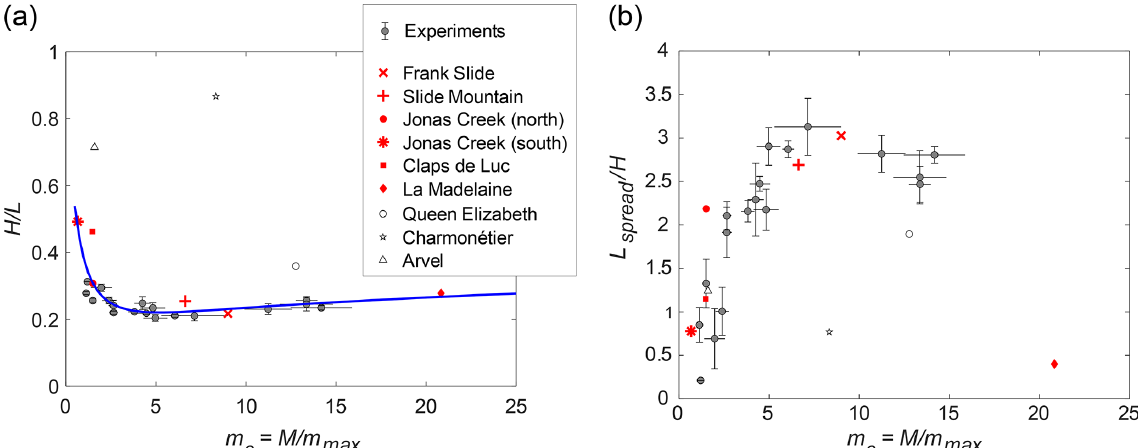
Figure 3. Heim’s ratio and the deposit length of experiments (this study) and natural rock avalanches (from Locat et al., 2006). (a) The Heim’s ratio of the analogue experiments (grey) and from the rock avalanches (red shows the selected set, and open shows discarded avalanches). The blue line represents the best fit of Eq. 8 to experimental and natural data with parameters α = − 1 . 0, β = 1 . 5, γ = 0 . 11. (b) The deposit’s lengths. In both panels, the grey circles represent the average value of a set of 4–15 experiments, and the error bars give the standard error of the set. Note the opposite trends of the two curves, suggesting an intrinsic relationship between spreading and